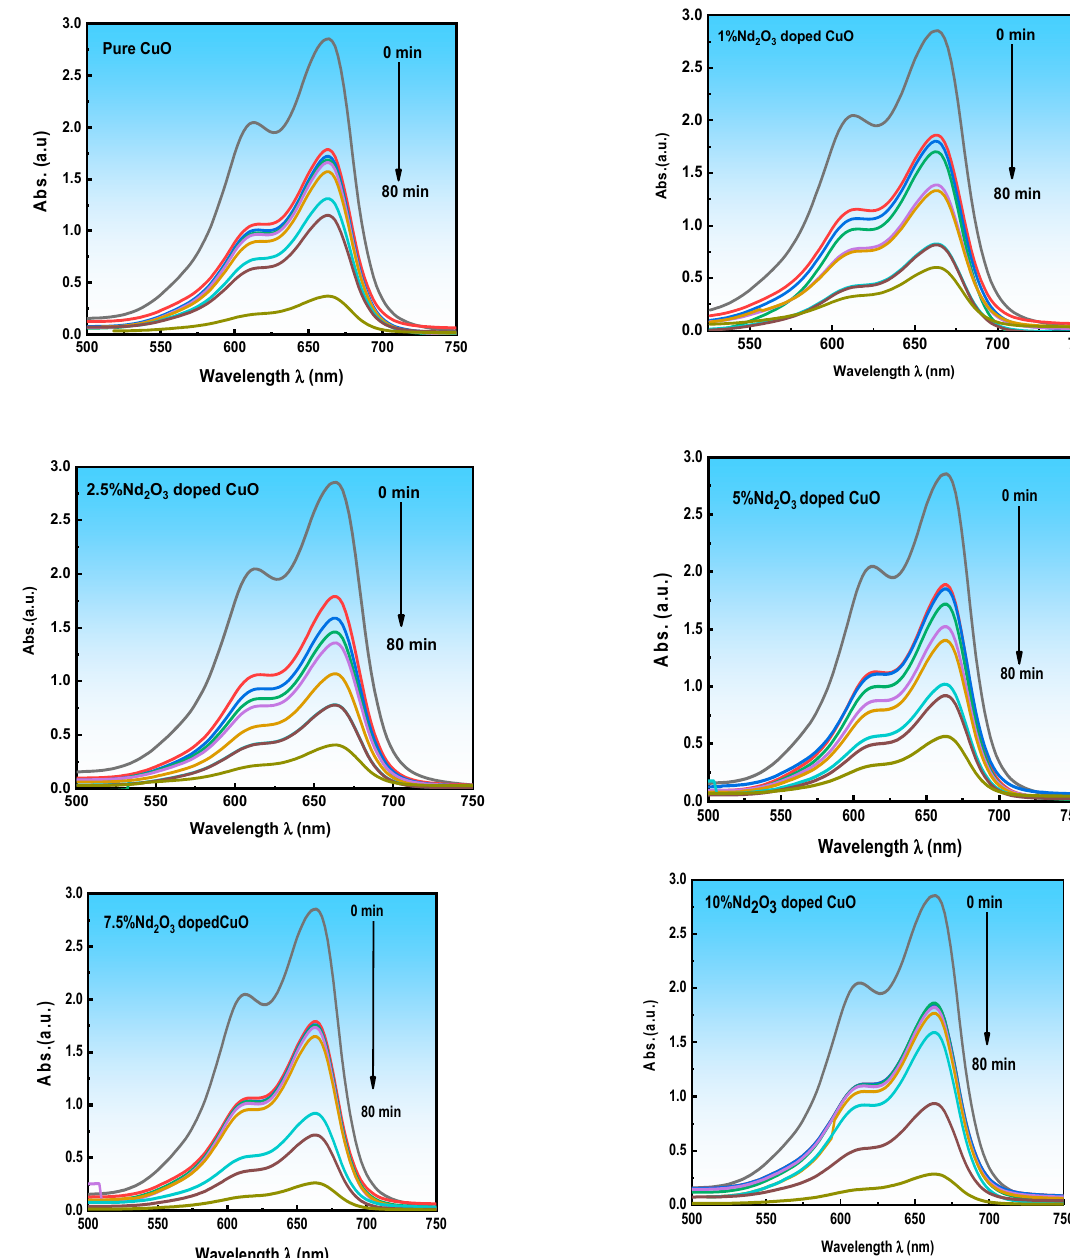
where absorption at 0 min illumination is A o (mg.L − 1 ), and absorption at irradiation time t (min), is A. The k values for CuO and Nd 2 O 3 doped CuO nanoparticles are depicted in Figure 6. The higher the doping level, the higher the rate of deterioration up to 7.5% Nd 2 O 3 doped CuO nanoparticle, while at 10% Nd 2 O 3 doped CuO nanoparticle, the degradation begins to decrease, which means that 7.5% Nd 2 O 3 doped CuO nanoparticle has the highest degradation rate constant of 0.02274 min − 1 (as seen in Table 4).